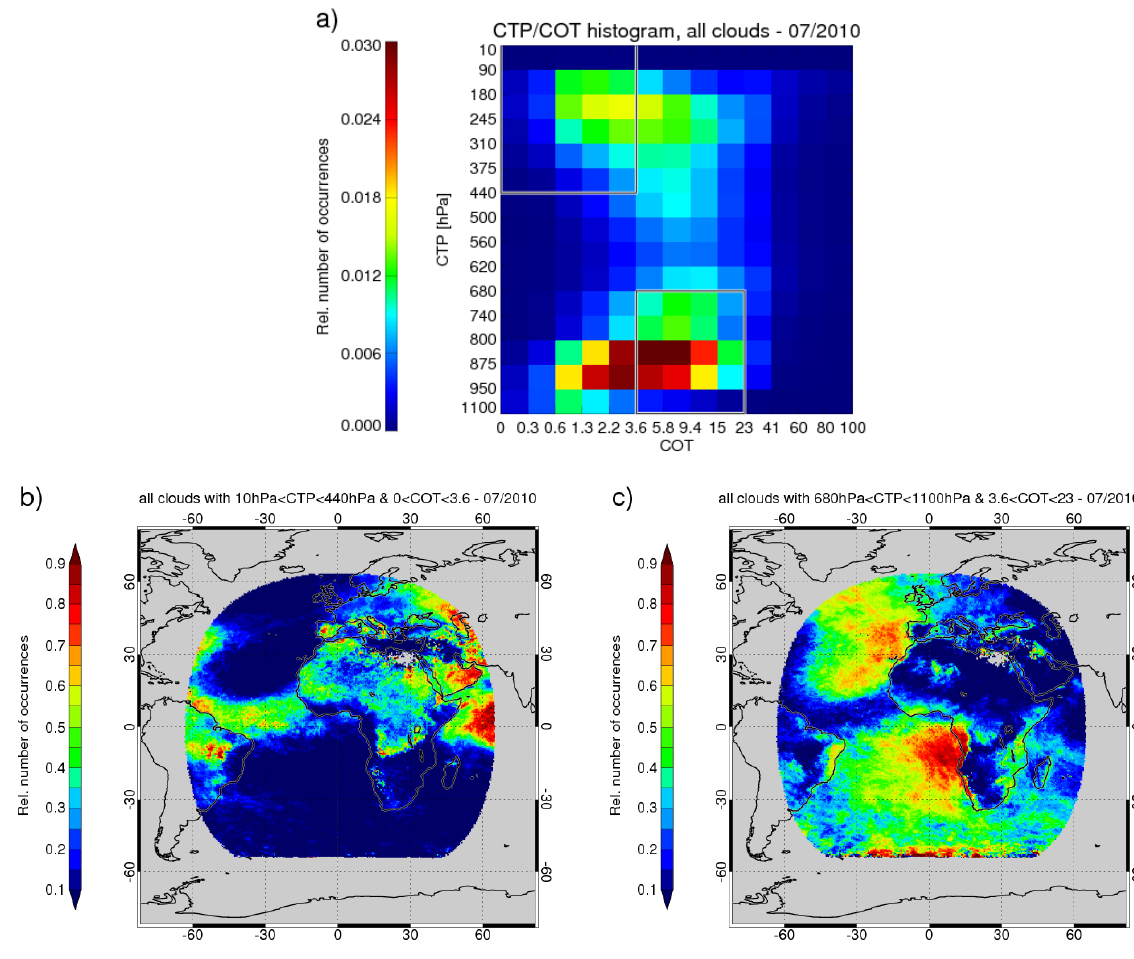
Fig. 6. (a) Joint cloud property histogram (JCH) when aggregated over the covered disc (as shown in panels (b) and (c) ). The values have been normalized with the total number of cloud occurrences. (b) Relative number of occurrences of cirrus clouds (as defined in Rossow and Schiffer, 1999) with cloud top above 440hPa, and COT between 0 and 3.6. (c) Relative number of occurrences of stratocumulus clouds with cloud top below 680hPa, and COT between 3.6 and 23. All data are for July 2010. Grey shaded areas mark regions without cloud observation in this month.